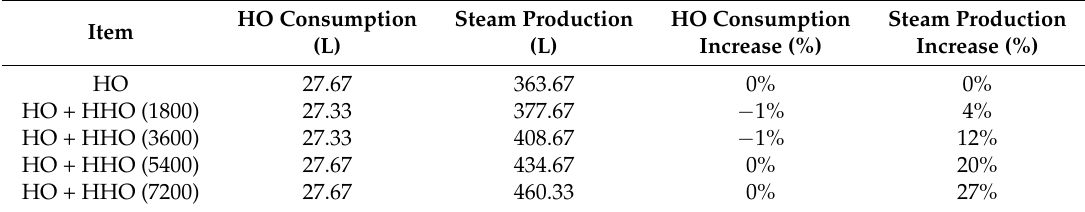
Table 8. Average increases (%) of HO consumption and steam production when combining HO with various amounts of HHO.